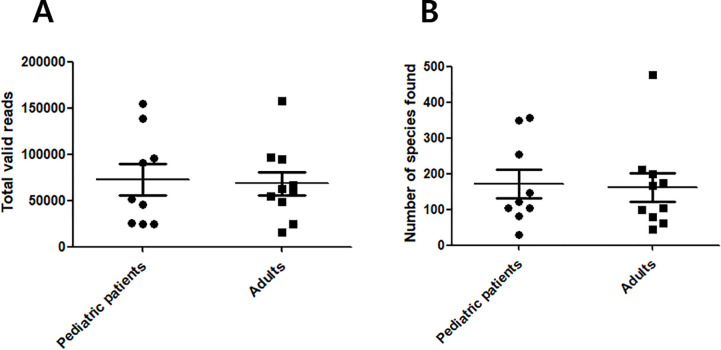
Sequence read counts from middle meatal samples.(A) Comparison of total valid reads and (B) comparison of number of species found between adult and pediatric CRS patients. There was no statistically significant difference between the two groups in both comparisons.